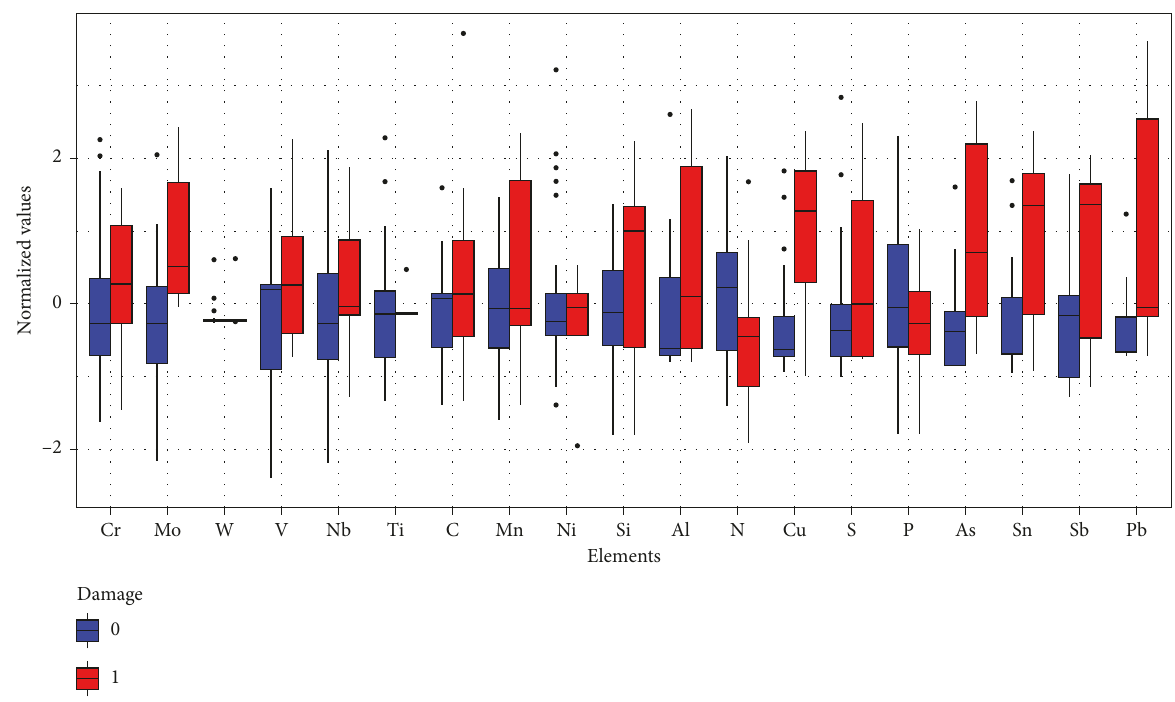
Figure 15: Trend showing how the level of the elements Mo, V, Nb, C, Mn, Si, Al, Cu, S, As, Sn, Sb, and Pb in Grade 91 steels varies for damage susceptible steels (red boxes) and damage resistant steels (blue